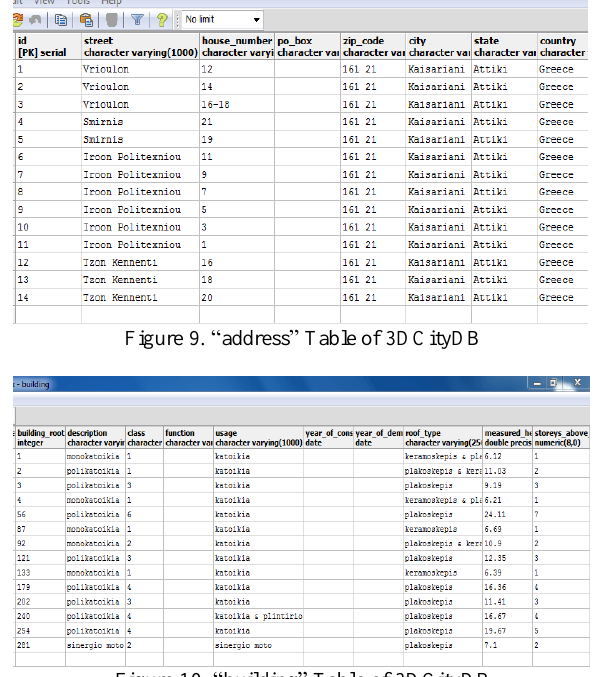
Figure 10. “building” Table of 3DCityDB